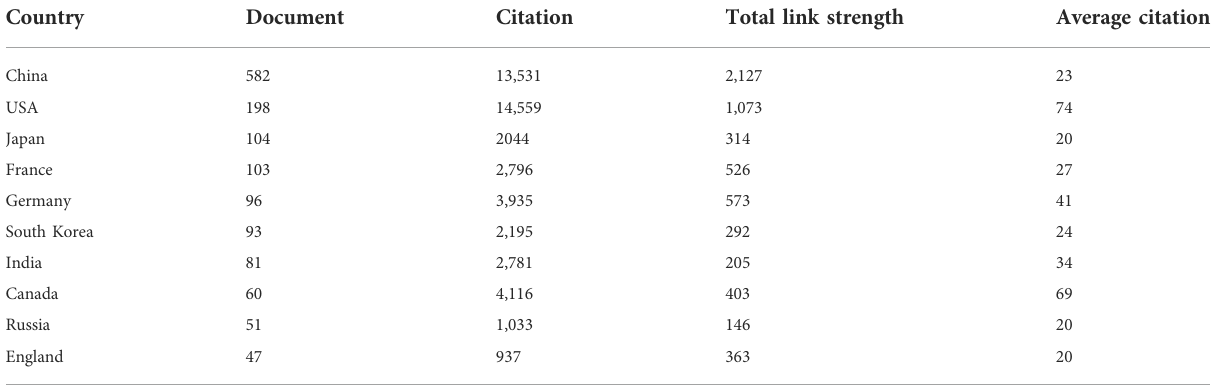
TABLE 6 Top 10 countries in terms of the number of articles published in